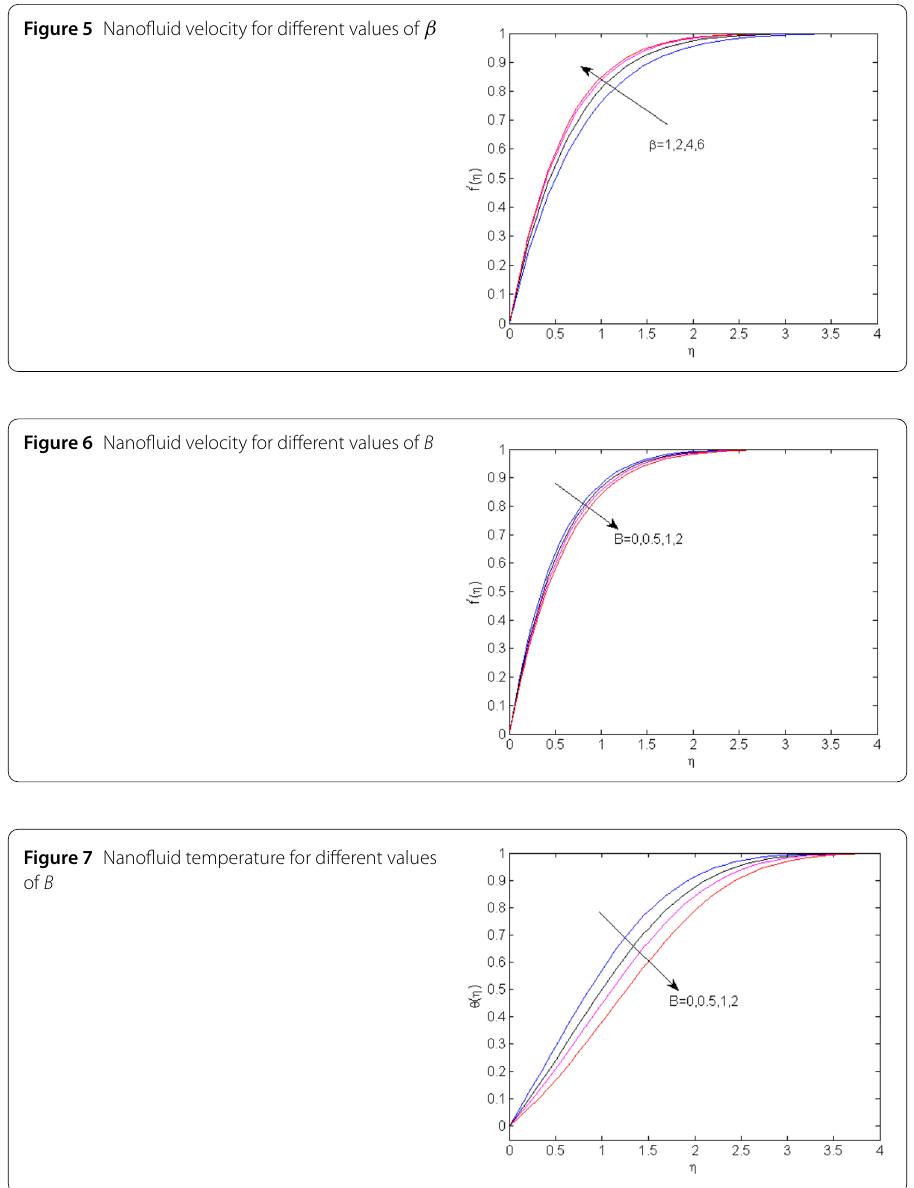
Figure 5 Nanofluid velocity for different values of β